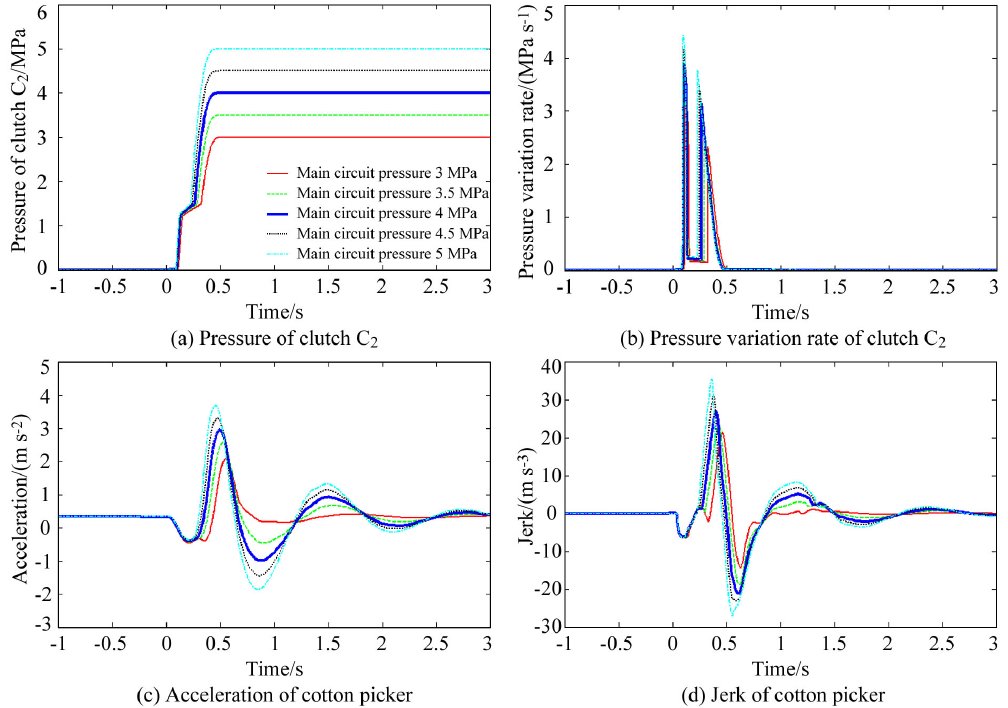
Figure 6. Influence of the main circuit pressure on the shift quality of the cotton picker.